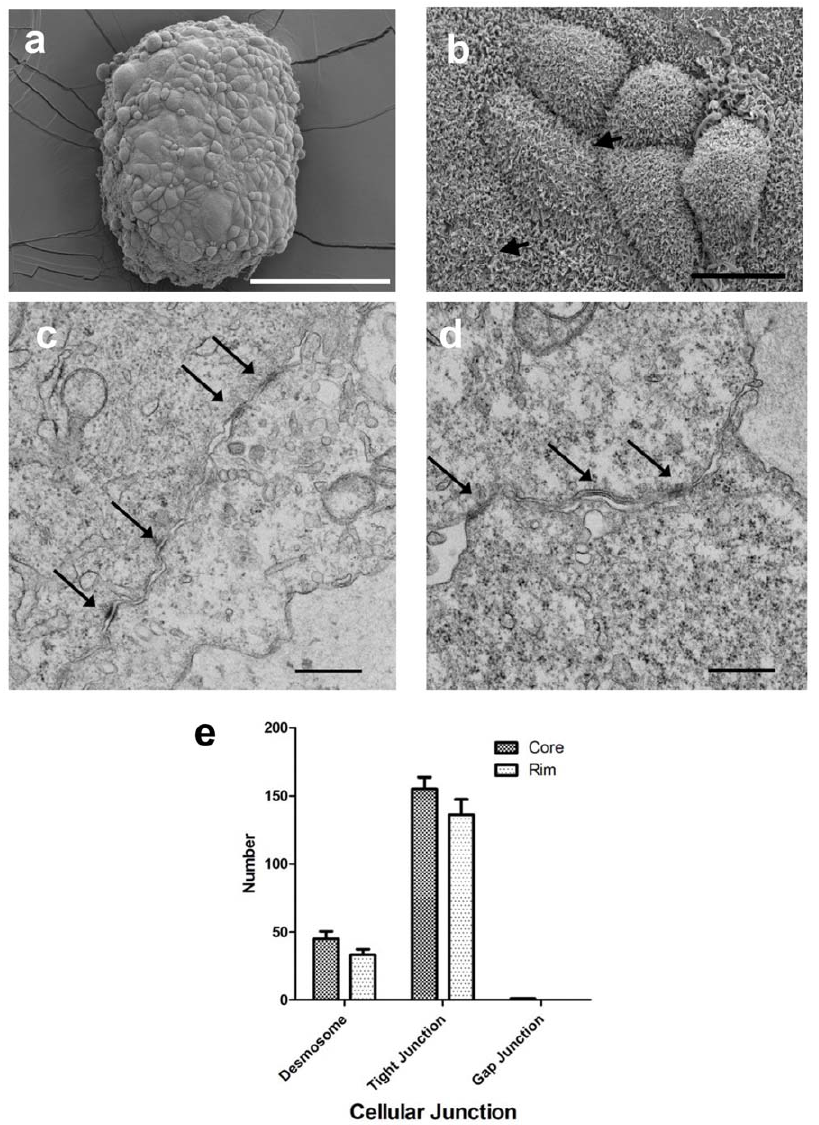
Figure 5. Electron microscopy of cell contacts in NCI-H226 mesothelioma spheroids. A and B . SEM analysis showing microvilli (arrow). Scale bars, 200 m m (A) and 10 m m (B). C and D . Ultrathin sections (TEM). Presence of intracellular tight junctions (arrow). Scale bar, 0.5 m m. E . Number of cellular junctions in the core and rim areas.